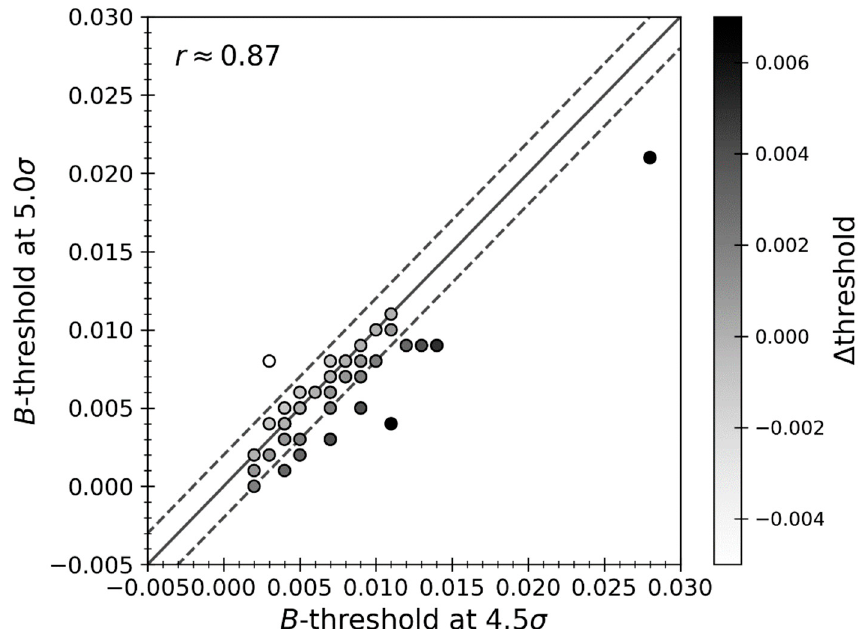
Figure 9. Scatter plot of the bottom thresholds at two different sigma values.